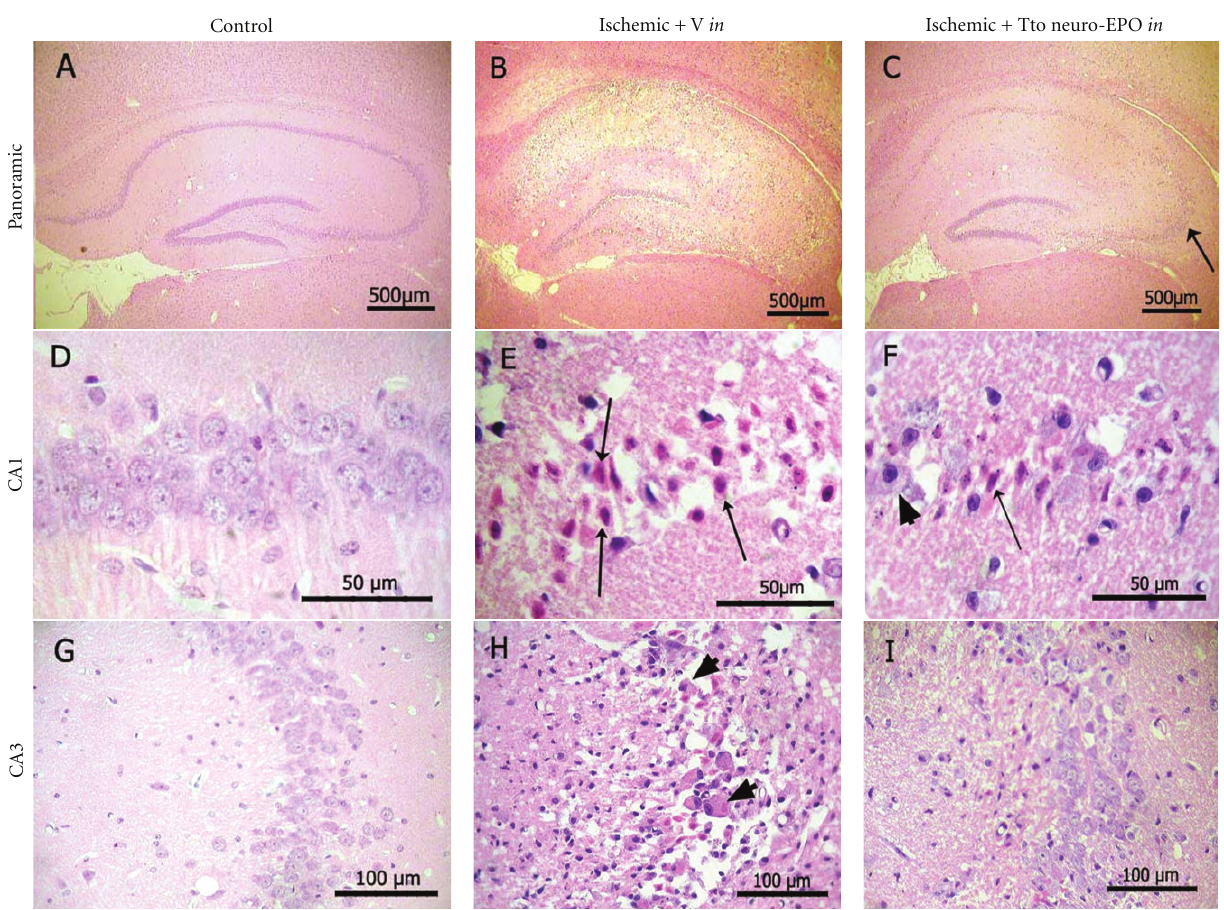
Figure 4: Model of focal ischemia. Dorsal hippocampus. Causes brain ischemia in the hippocampus at 7 days after occlusion (B, E, H). The Neuro-EPO protects the dorsal hippocampal CA3 sector in this model (C, I) and does not protect CA1 (F). H-E. A, B, C: Panoramic view. Arrow: conservation of CA3 neurons. D, E, F: Dorsal hippocampal CA1 sector. Arrows withdrawn neurons with pyknotic nuclei and eosinophilic cytoplasm. G, H, I Sector CA3 of the hippocampus. Arrowheads in E, F, and H macrophages with vacuolated